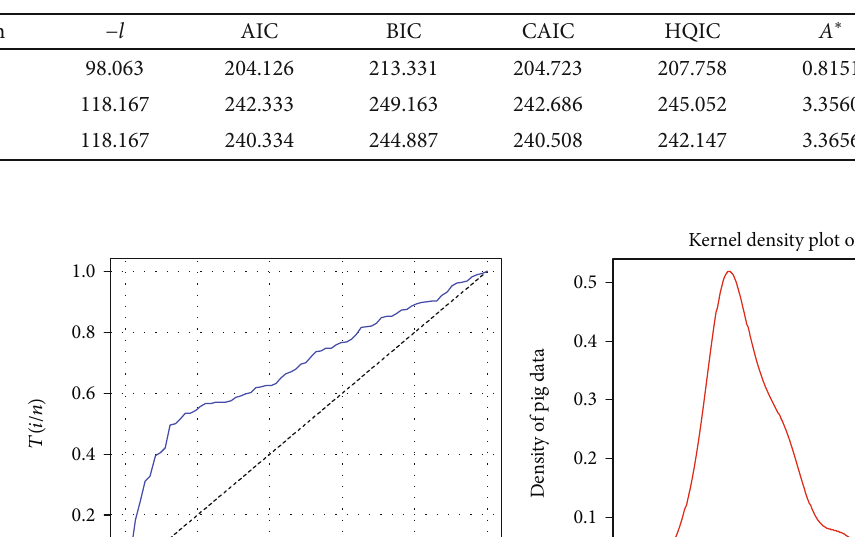
Table 4: Selection criterion statistics for pig data.